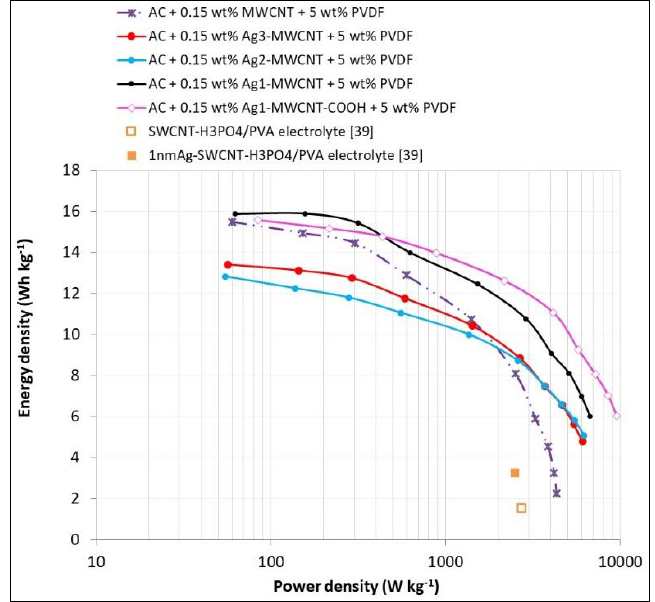
Figure 8. Ragone plot for EDLCs with different types of composite electrode coatings, created from the results of galvanostatic discharge at different currents in the range of 0 – 2.7 V. The energy density and power density values are per total mass (kg) of the two composite electrodes in the EDLC cell. Also shown is a comparison with experimental data from a study by Wee et al. [39].